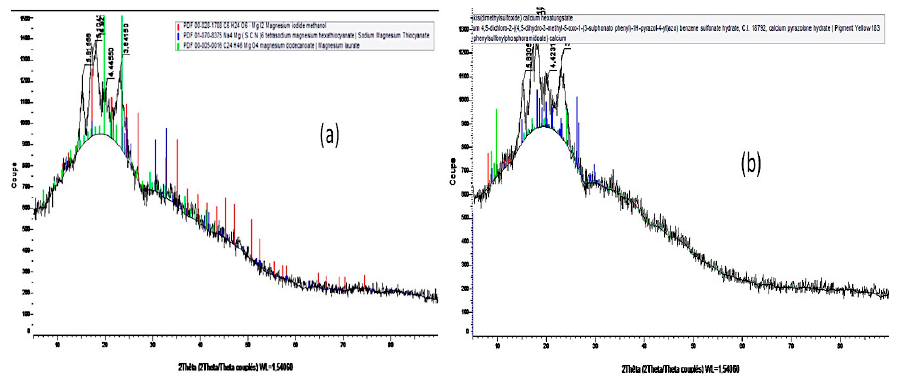
Figure 2. X-ray diffractograms of BS-HVL ( a ) and BC-HVL ( b ).